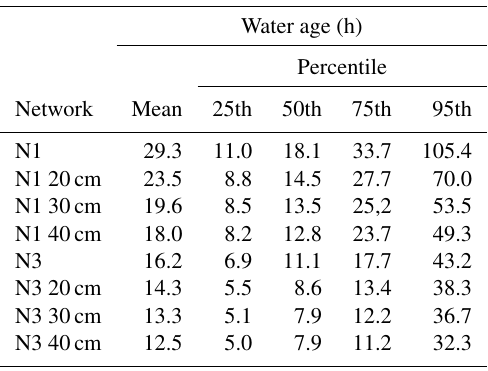
Table B4. Water ages, determined for the last 24h of a 168h sim- ulation, using a 1s water-quality time step and a 1h hydraulic